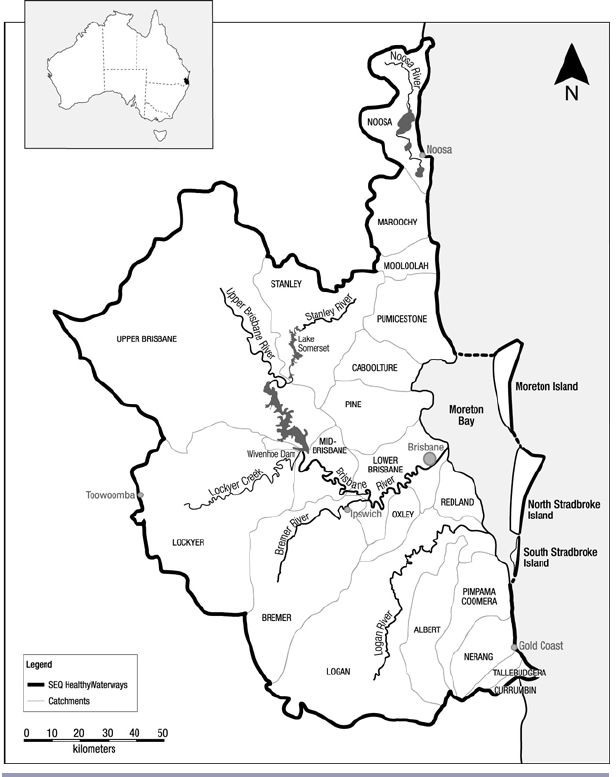
Fig. 1. Map of the Southeast Queensland region, Australia, showing major rivers and